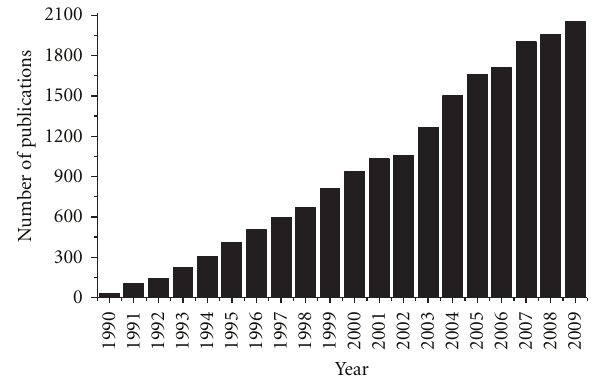
Figure 1: Yearly histogram of the papers dealing with the use of electrospray ionization after the Fenn’s introduction of electrospray ionization mass spectrometry to ionize the biomolecules in 1989. The information was obtained by searching ISI Web of Knowledge on 26.06.2011 for the term “Electrospray ionization.”